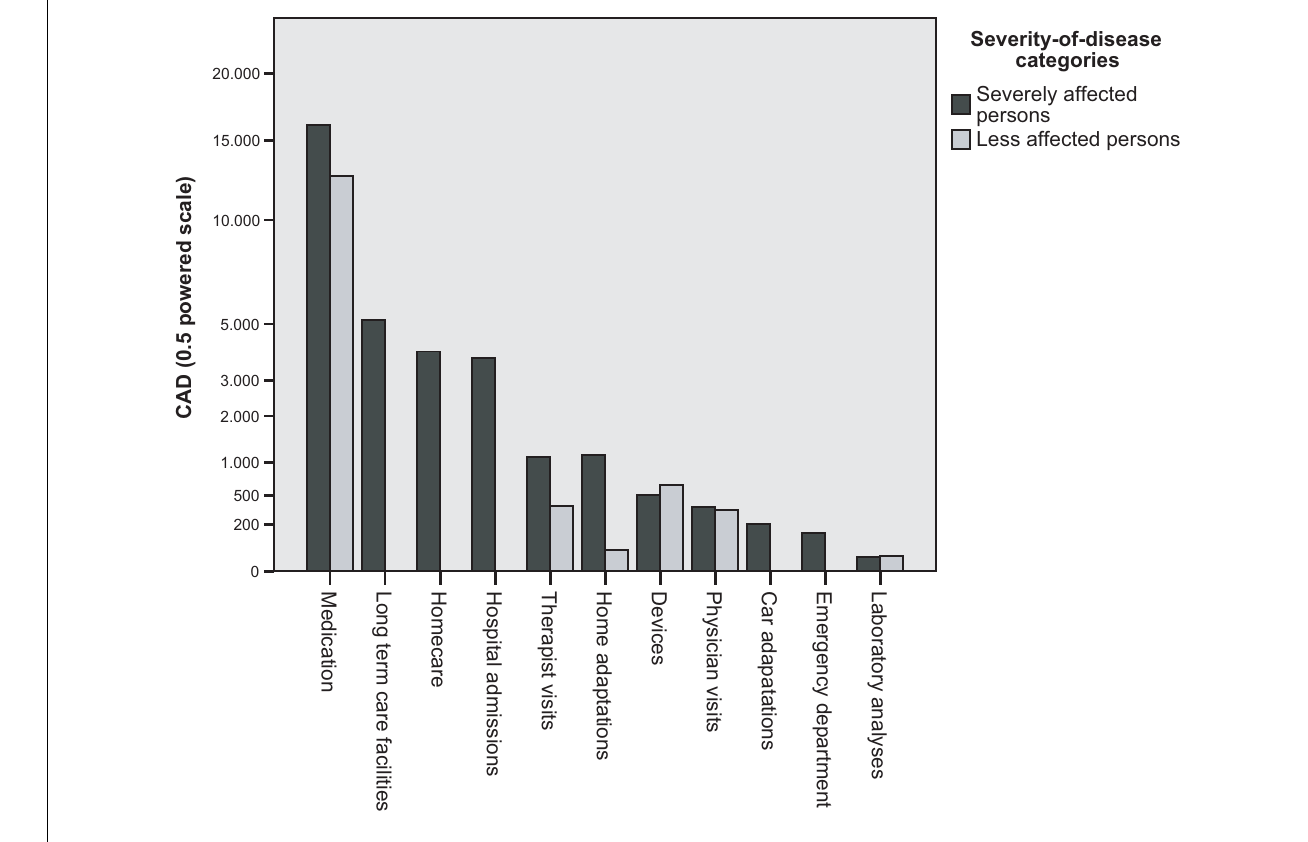
FIGURE 3 | Canadian survey: mean costs of persons with FRDA, by healthcare component and severity of disease category .